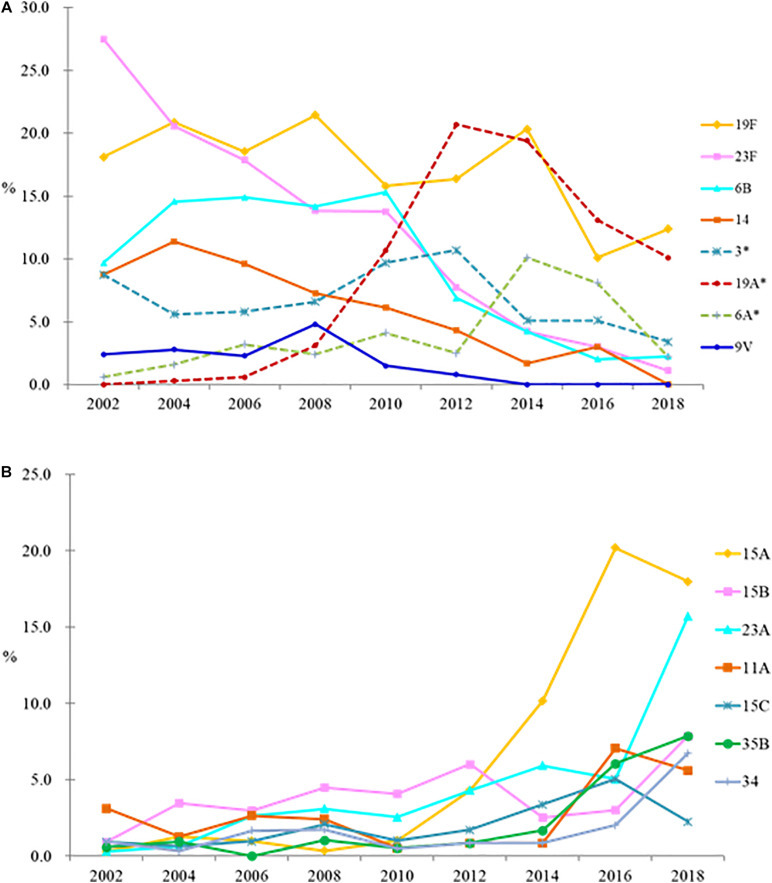
Changes in proportion of PCV7 and PCV13 serotypes (A), and non-PCV13 serotypes (B), among Streptococcus pneumoniae isolates in the pre-PCV (2002–2004), PCV7 (2006–2010), and PCV13 (2014–2018) eras. ∗, PCV13/non-PCV7 serotypes. Serotypes 4 and 5 plus serogroups 7 and 18 together comprised 1% of all isolates so are not shown, and serotype 1 was not detected.